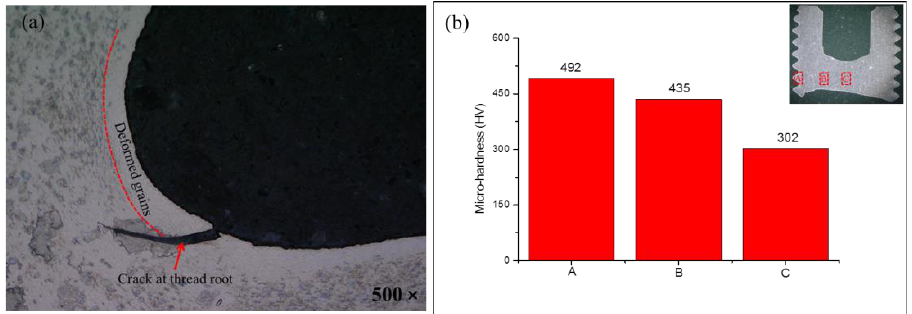
Figure 9. ( a ) Initial crack and ( b ) micro-hardness in marked areas of fracture bolt.